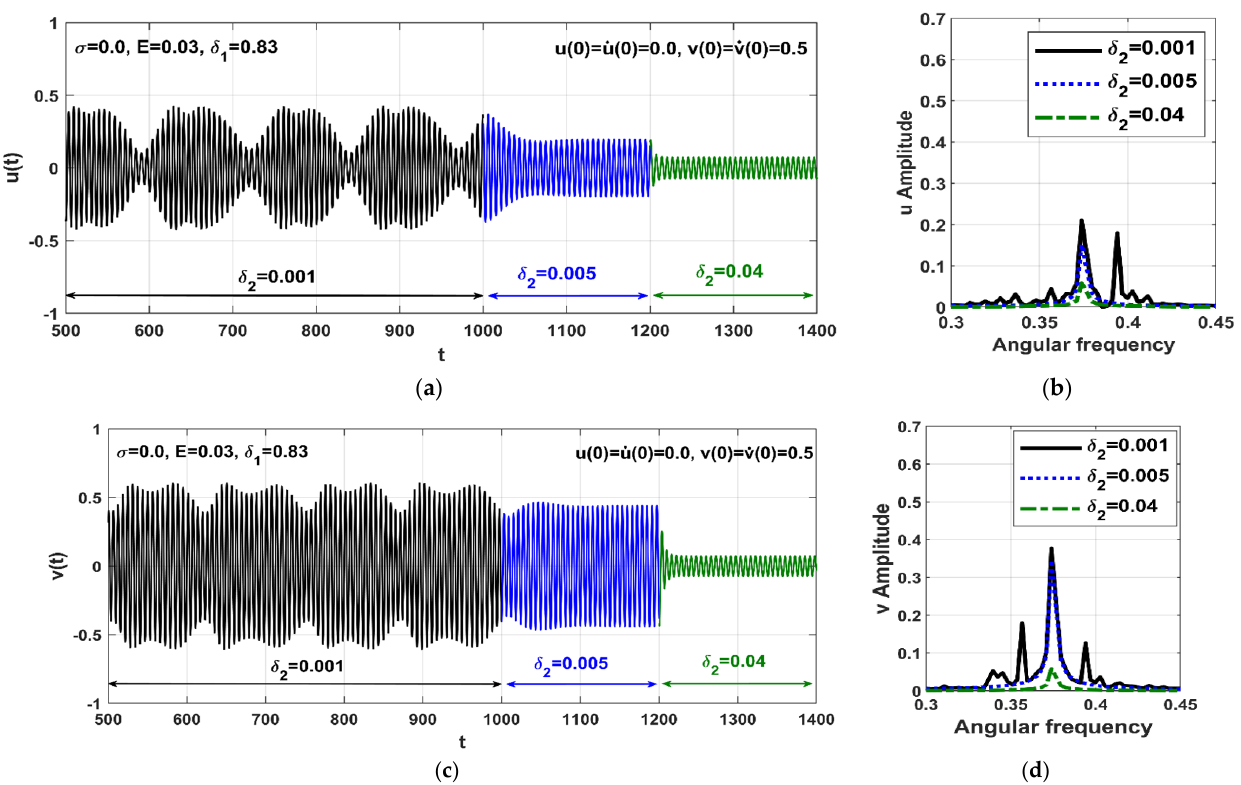
Figure 17. Time-response and the corresponding frequency-spectrum of the controlled Jeffcott-rotor according to Figure 16 at the initial conditions 𝑢(0) = 𝑢(cid:4662)(0) = 𝑣(0) = 𝑣(cid:4662)(0) = 0 and parameter val- ues 𝜎 = 0,𝐸 = 0.03,𝜆 = 0.05,𝛿 (cid:2869) = 0.83 when increasing the derivative gain online from 𝛿 (cid:2870) = 0.0.001 to 𝛿 (cid:2870) = 0.005 at time 𝑡 = 1000 , and then from 𝛿 (cid:2870) = 0.005 to 𝛿 (cid:2870) = 0.04 at 𝑡 = 1200 : ( a , b ) the normalized temporal oscillations 𝑢(𝑡) and the corresponding frequency spectrum in 𝑋 direc- tion, ( c , d ) the normalized temporal oscillations 𝑣(𝑡) and the corresponding frequency spectrum in 𝑌 direction.